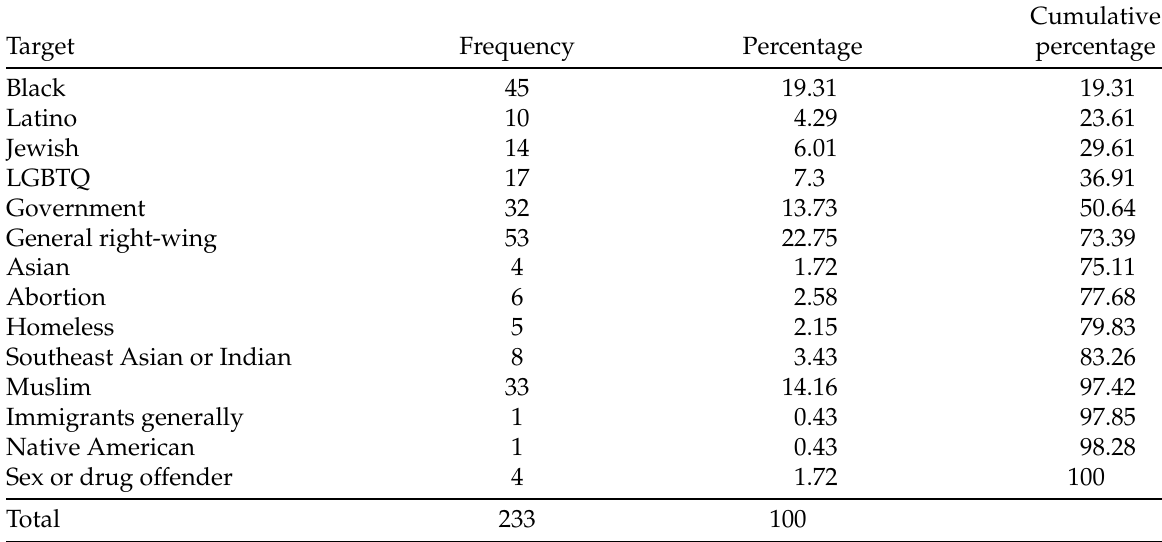
Table 3: Targets of right-wing attacks, 2000 to 2018